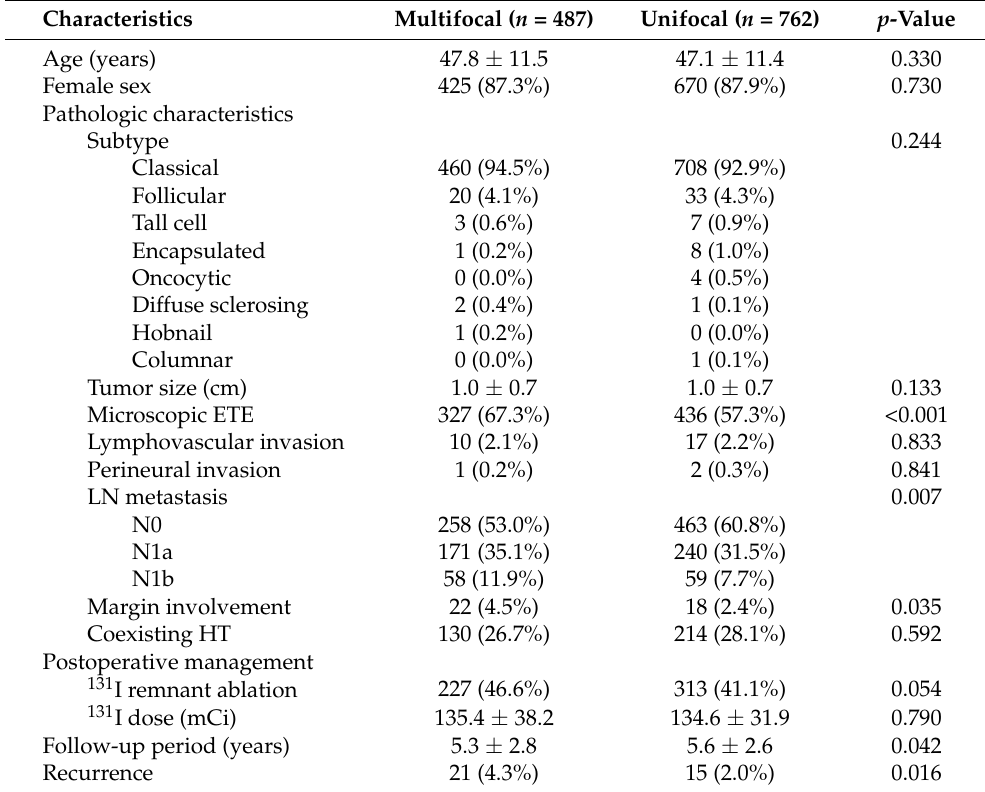
Table 1. Comparison of clinicopathological characteristics between patients with multifocal PTCs and those with unifocal